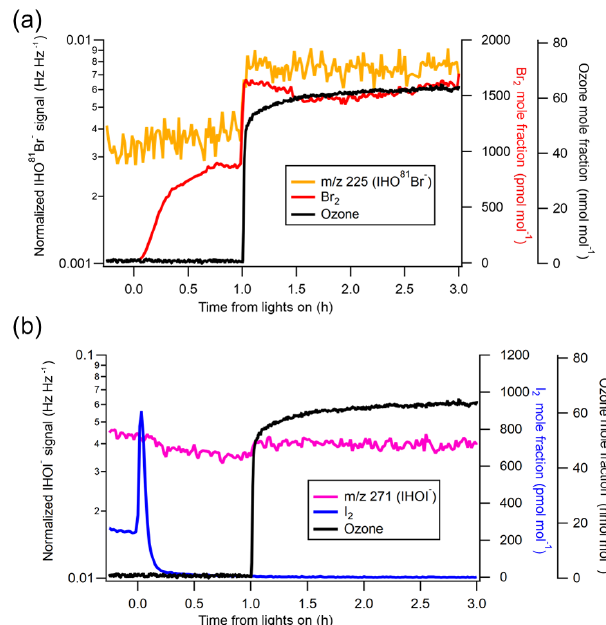
Figure 4. Normalized, background-subtracted HOX signals from Experiment SW5, pH = 1.8. (a) Comparison of Br 2 mole fractions to HOBr ( m/z 225). Note that the HOBr signal should be consid- ered only qualitatively as its identity could not be confirmed using isotopic ratios with m/z 223. (b) Effect of O 3 on I 2 and HOI.